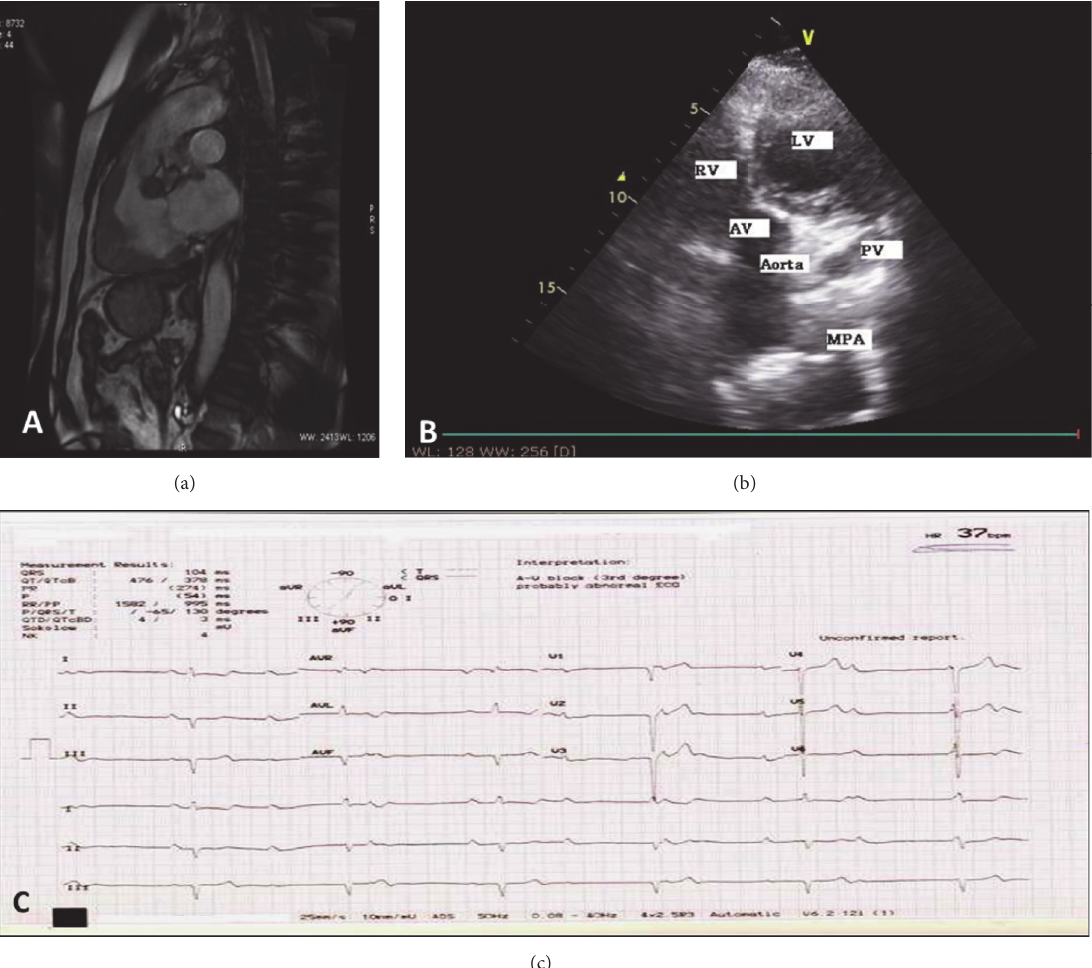
Figure 1: (a) Cardiothoracic MRI depicting right ventricular hypertrophy; (b) echocardiography image demonstrating transposed ventricles; (c) electrocardiogram interpreting AV block and low heart